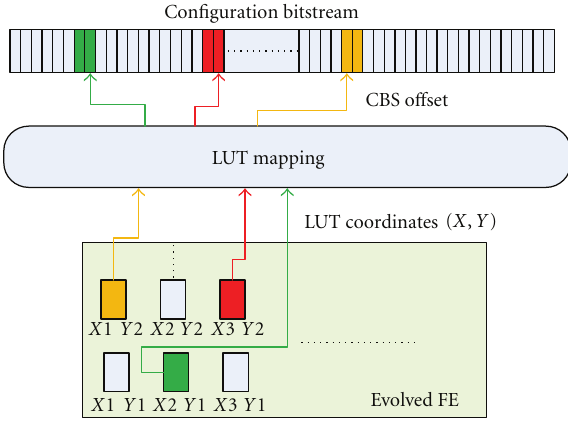
Figure 4: Mapping from LUT coordinates to CBS o ff